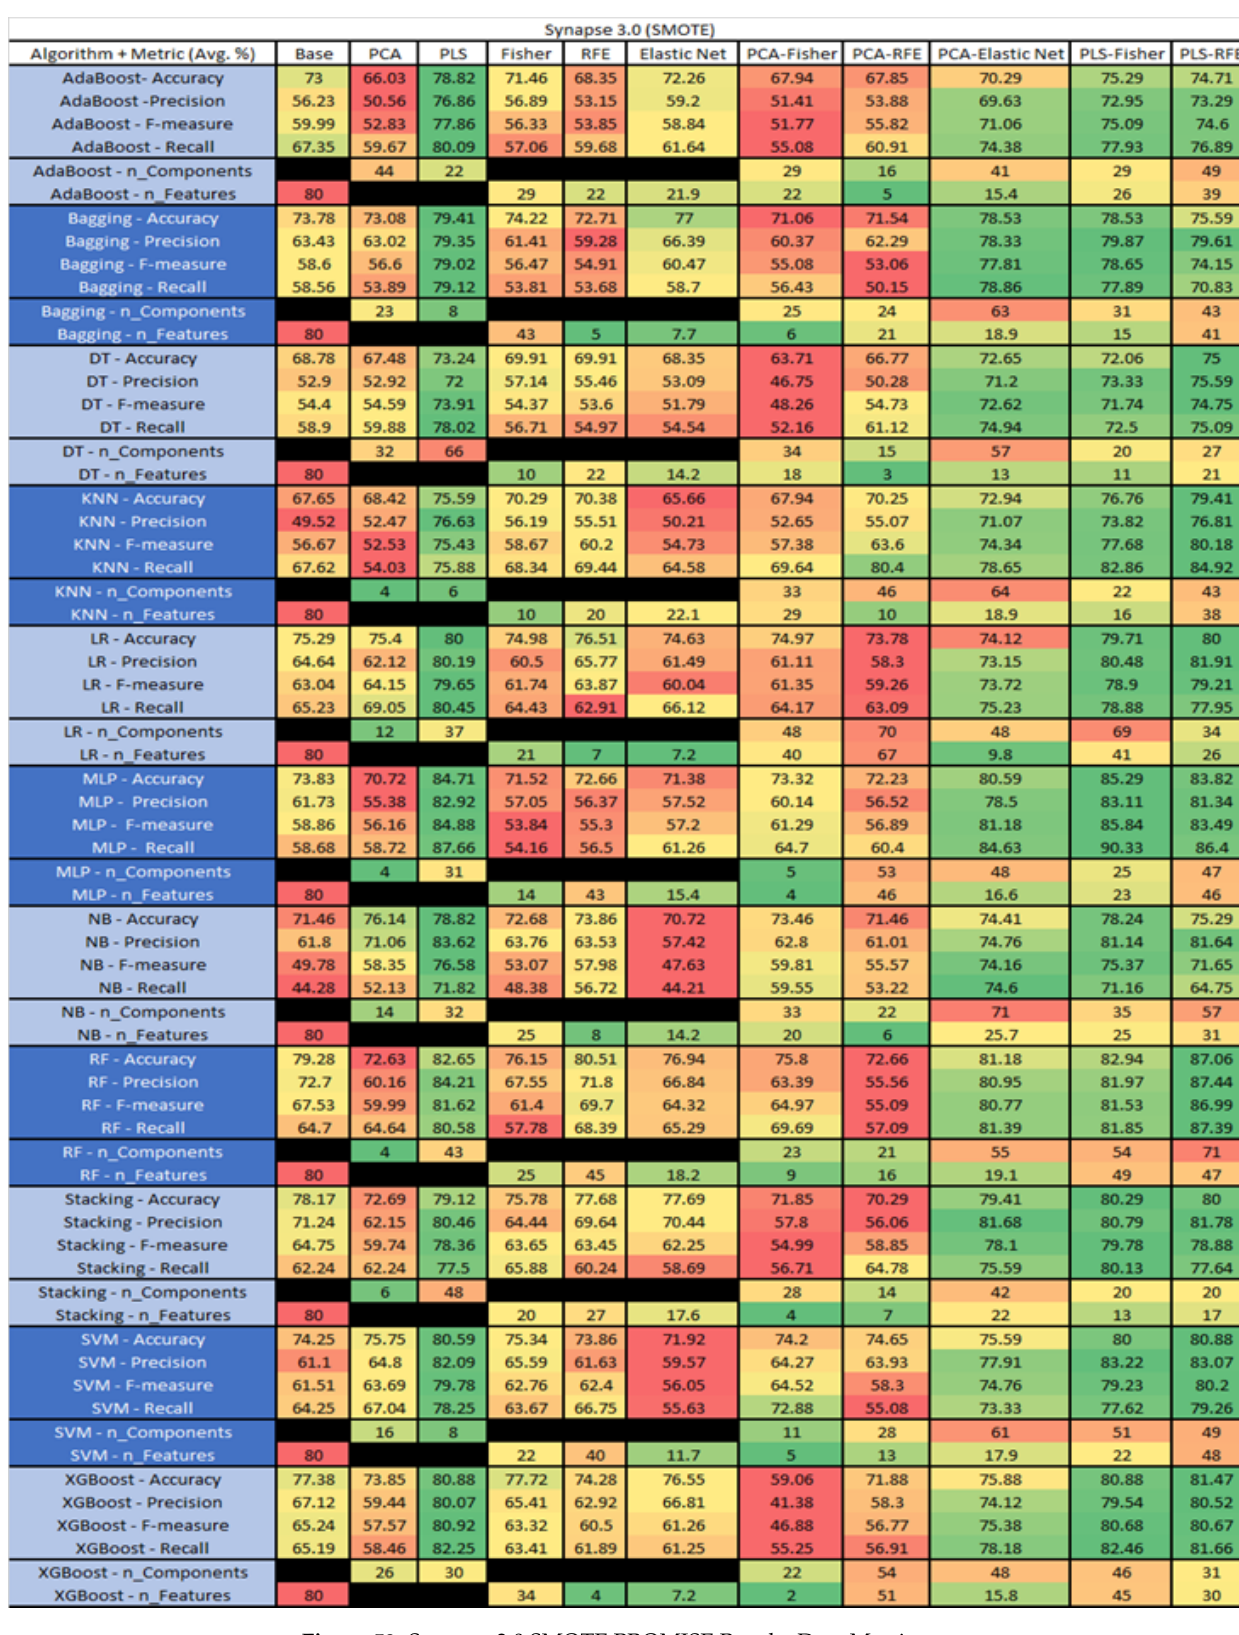
Figure 53. Synapse 3.0 SMOTE PROMISE Results Data